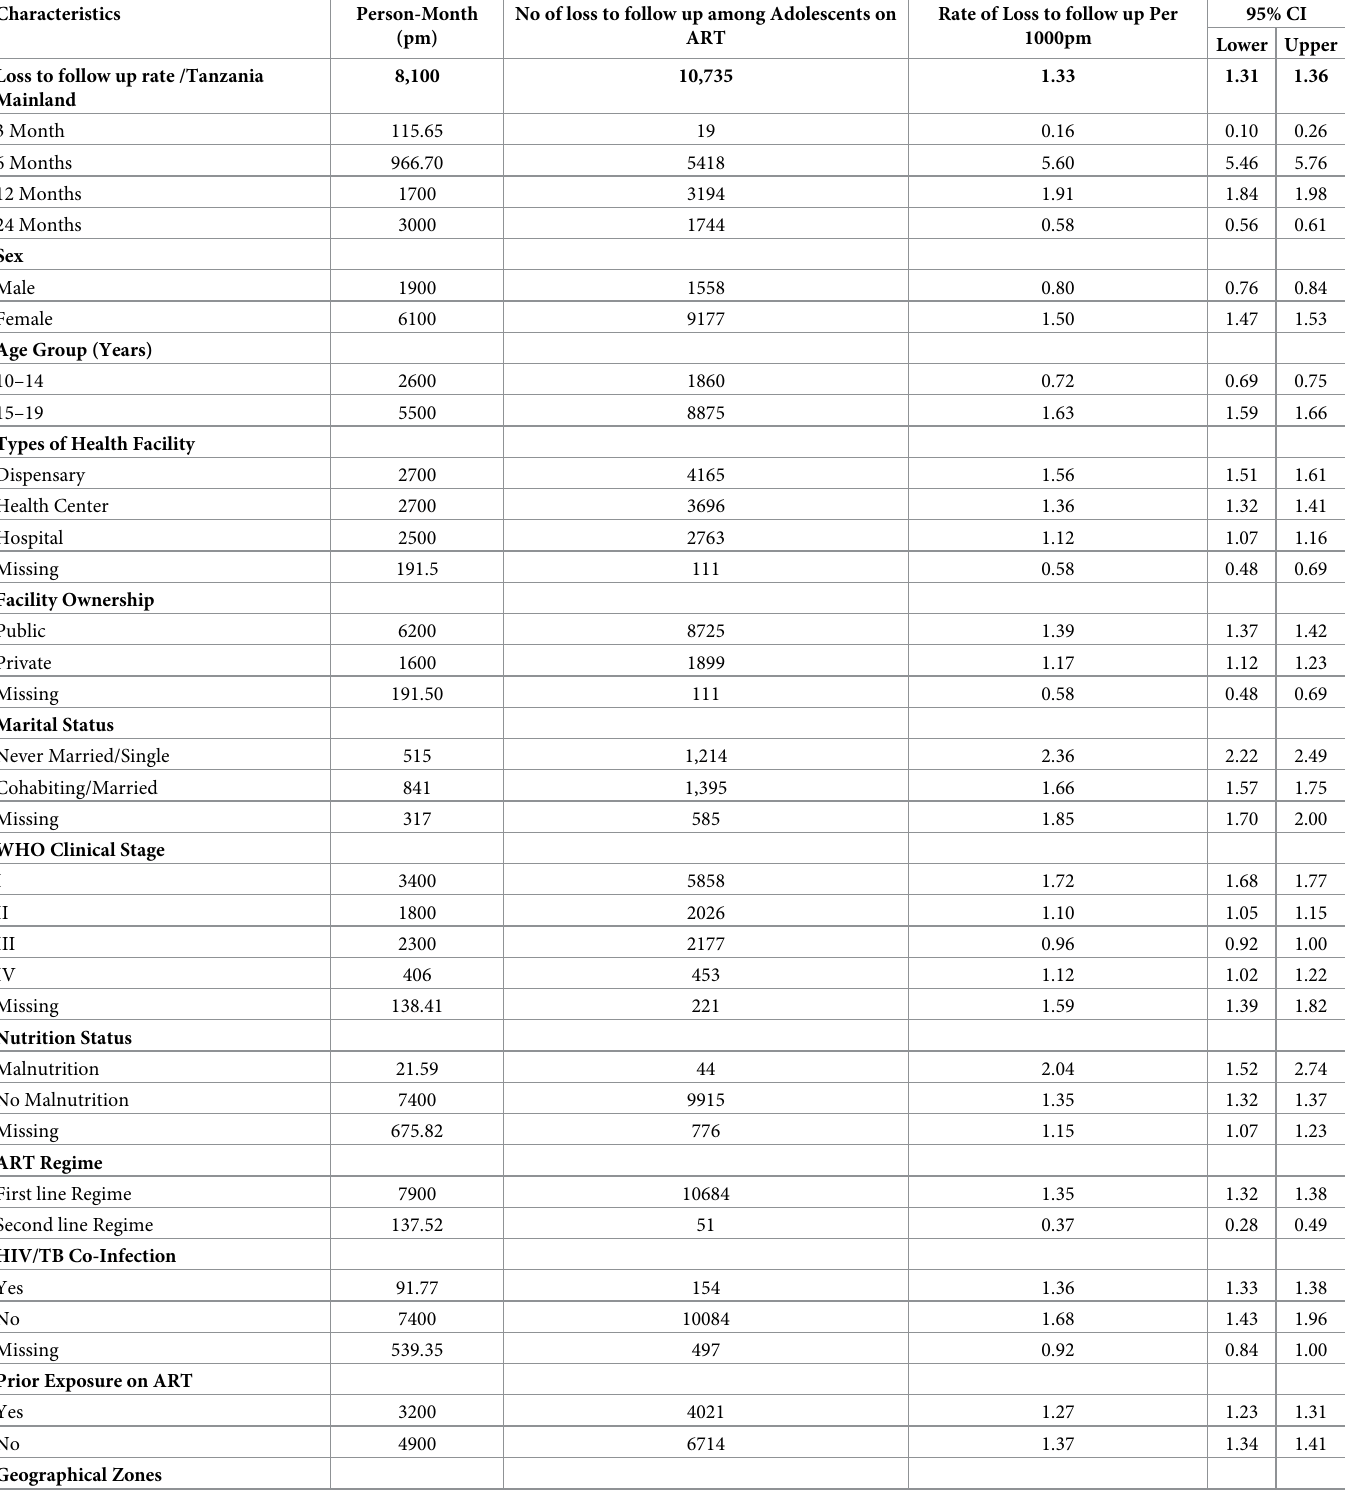
Table 2. Rate of loss to follow up among adolescents on ART.